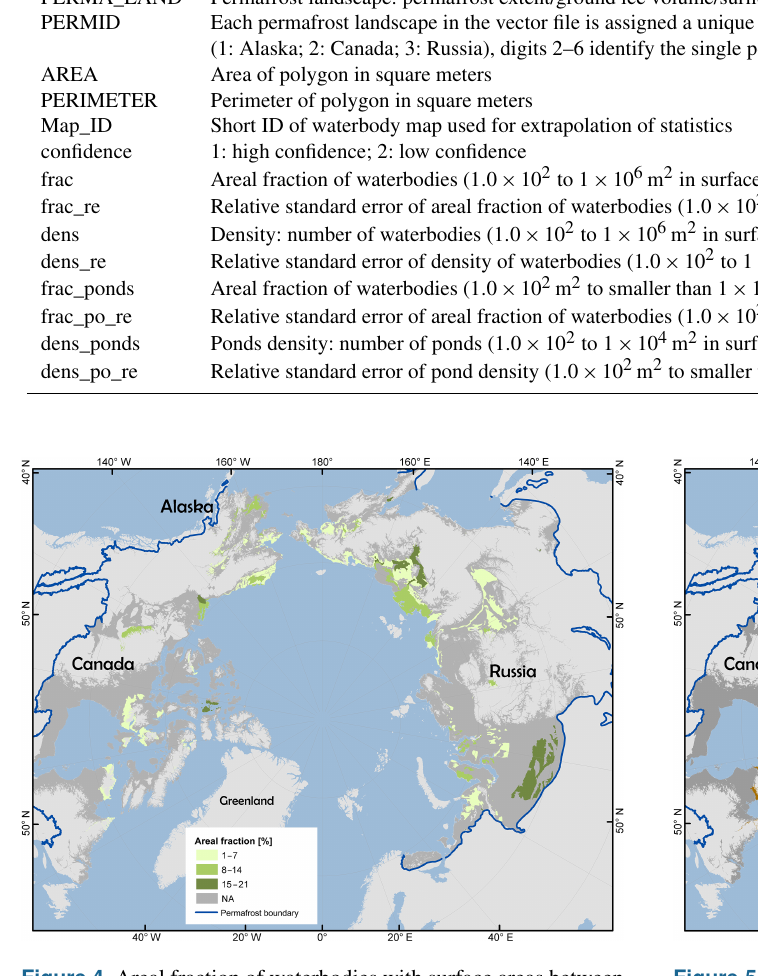
Figure 4. Areal fraction of waterbodies with surface areas between 1 . 0 × 10 2 and 1 . 0 × 10 6 m 2 . Permafrost boundary was derived from the regional databases.